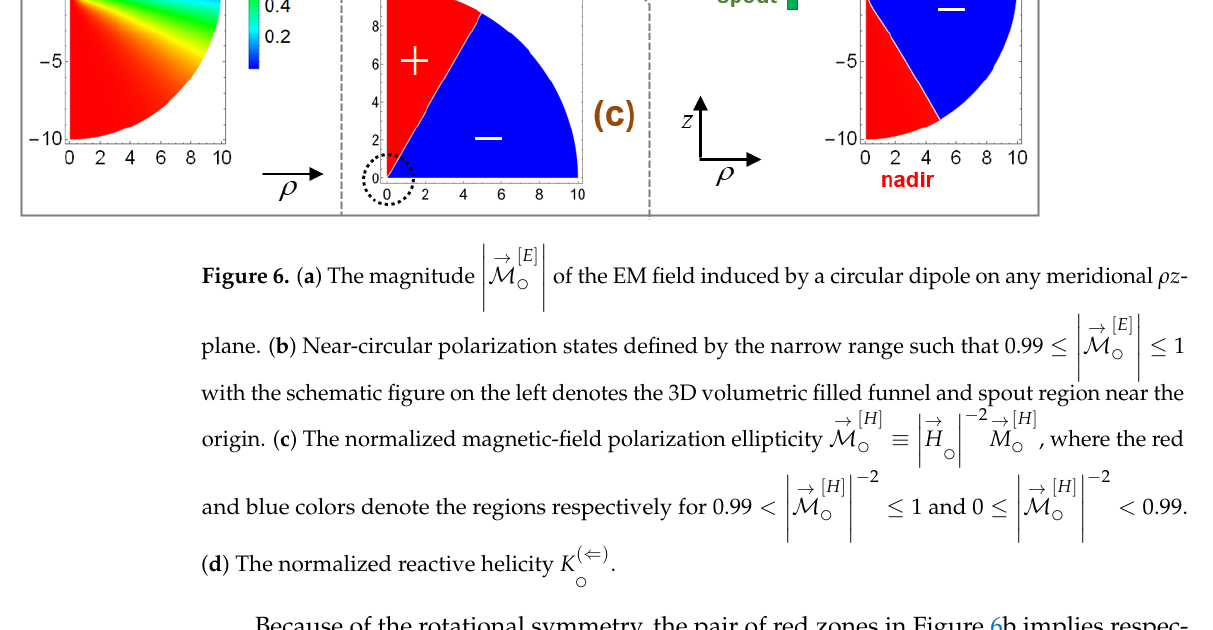
law for time-oscillatory fields [30]. Figure 1a illustrates this conservation law. Notwithstanding, it has been seldom recognized that meaning either source or sink for